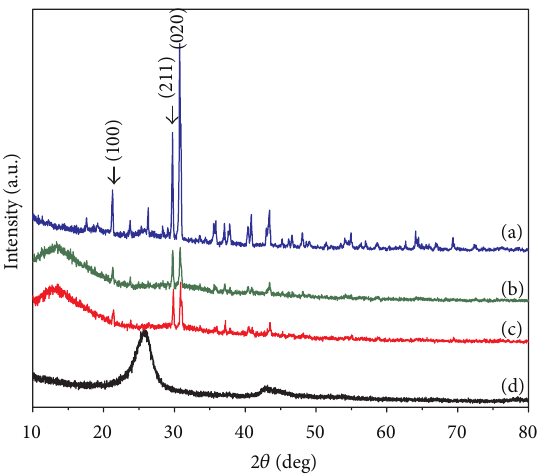
Figure 4: TGA thermograms of CNT-COOH (a), CNT/PANI com- posite prepared in HCl (b) and HNO 3 (c) medium, and pure PANI (d), obtained with a ramping rate of 10 ∘ C/min under a N 2